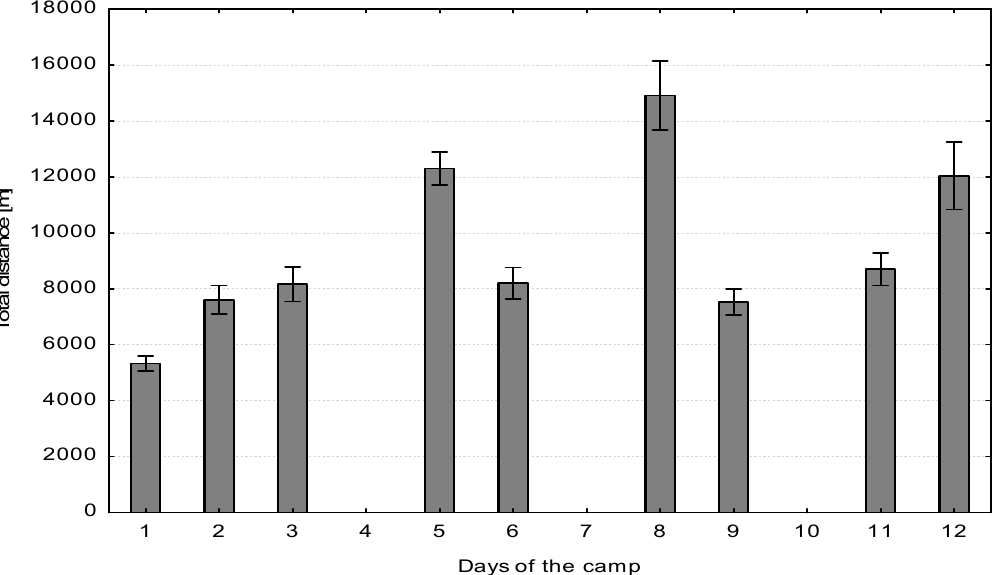
Int. J. Environ. Res. Public Health 2020 , 17 , x Figure 1. Total distance covered during each day of the camp. Figure 1. Total distance covered during each day of the camp.